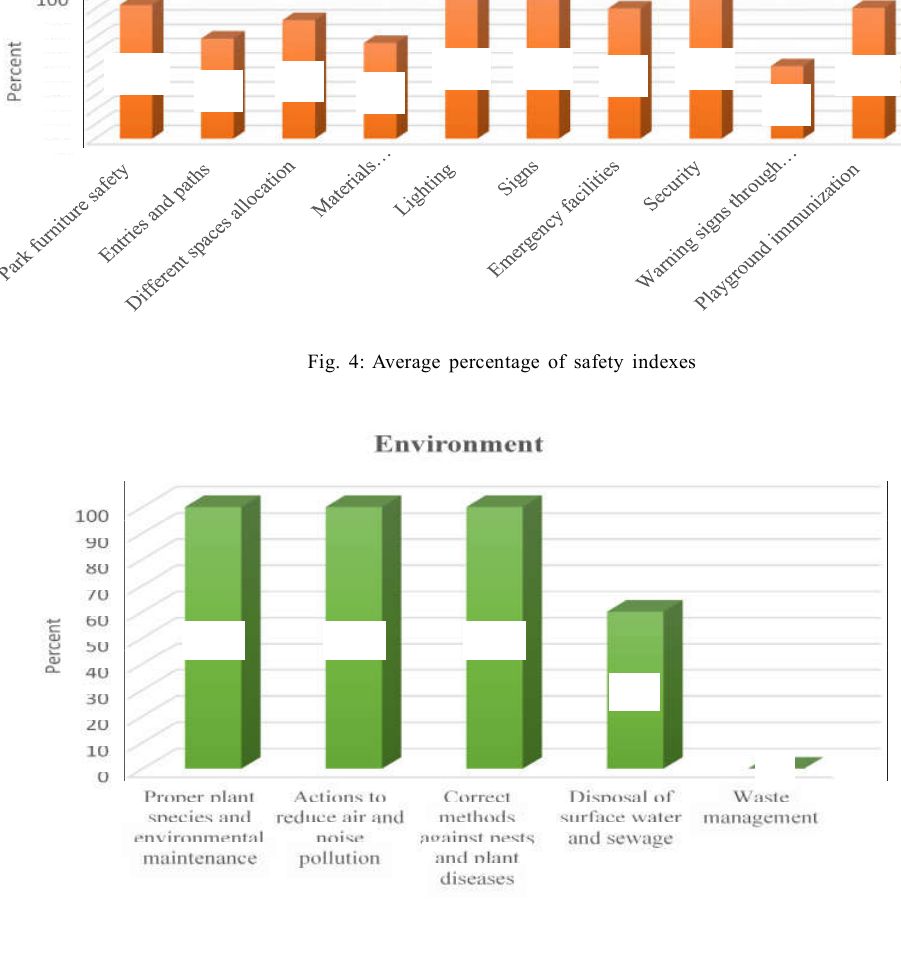
Fig. 5: Average percentage of environmental